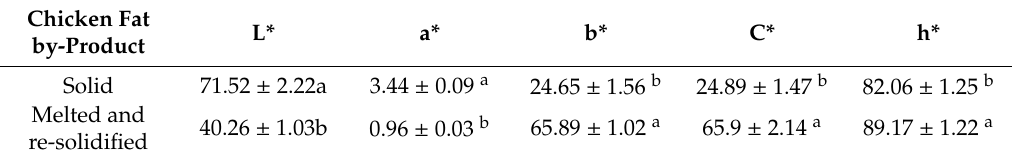
Table 4. Colour parameters [(L*) lightness, (a*) redness, (b*) yellowness, (C*) chroma or saturation index, (h*) hue] of chicken fat by-products (solid fat and melted and re-solidified